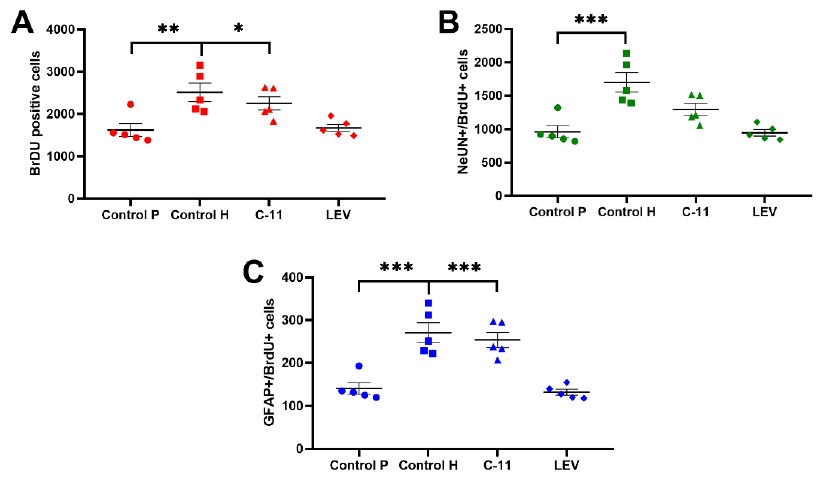
Figure 2. Evaluation of the neurogenesis process after the long-term administration of C11 and levetiracetam (LEV) in mice after pilocarpine (PILO)-induced status epilepticus (SE). ( A )—The effect of long-term treatment with C11 and LEV on the total BrDU cells of PILO mice. ( B )—The effect of long-term treatment with C11 and LEV on the newborn neurons of PILO mice. ( C )—The effect of long-term treatment with C11 and LEV on the newborn astrocytes of PILO mice. The numbers of cells represent an estimate of the total number of positively labeled cells in the subgranular zone (SGZ) and granular cell layer (GCL) of the dentate gyrus (DG) of PILO mice in both hemispheres. The results were analyzed using one-way analysis of variance (ANOVA), followed by Dunnett’s test for multiple comparisons. Each bar represents the mean for five mice; error bars are S.E.M. (* p < 0.05, ** p < 0.01, and *** p < 0.001; n = 5).